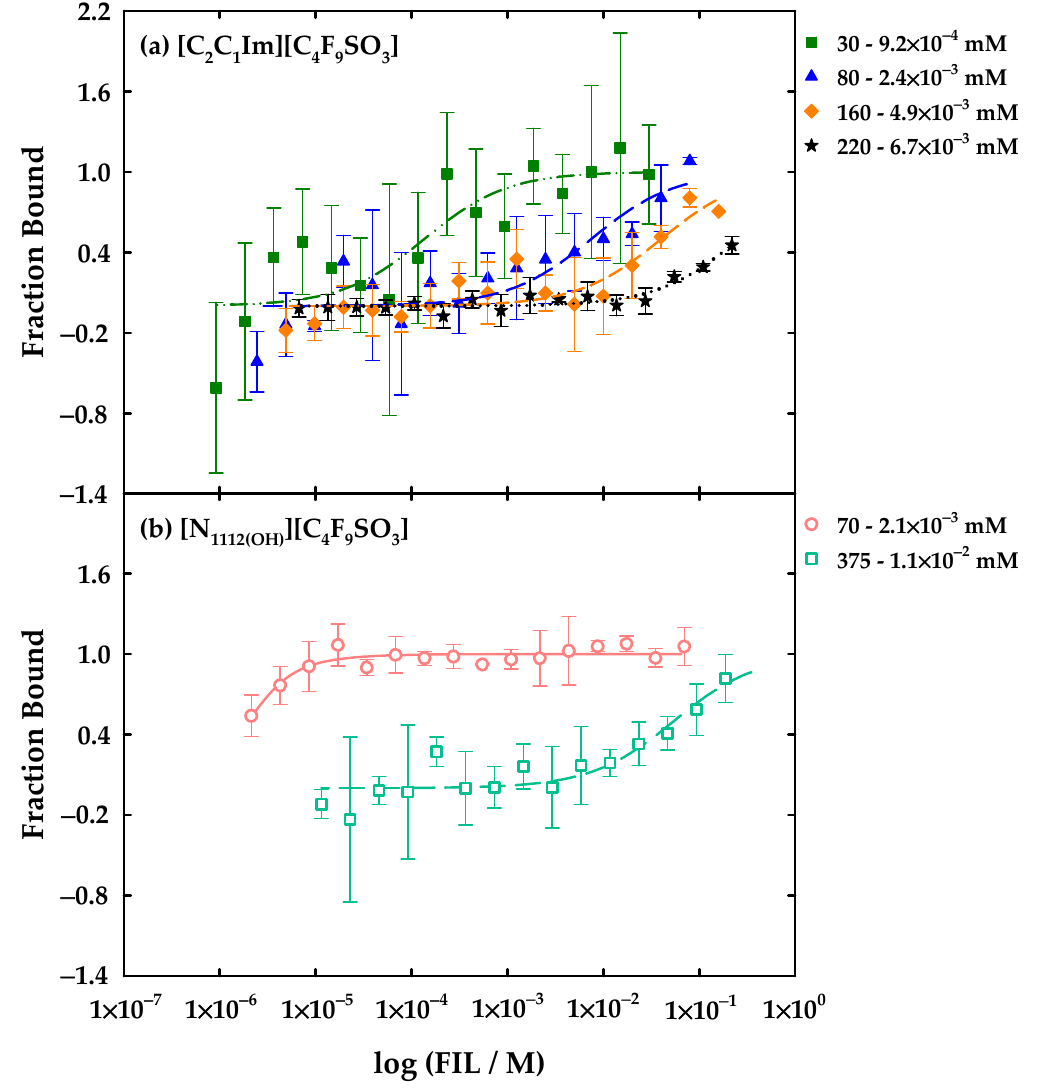
Figure 9. MST analysis of the interaction between the labelled IFN- α at 2.7 μ M and the different concentrations of ( a ) [C 2 C 1 Im][C 4 F 9 SO 3 ] and ( b ) [N 1112(OH) ][C 4 F 9 SO 3 ] that yield binding affinity. All the samples were measured in 5 mM NaH 2 PO 4 (pH = 7.4) at 25 °C. The error bars represent the standard deviations from the triplicate assays. Table 2. Determined dissociation constants K d by the analysis of the fitting of the MST dose-curve responses.